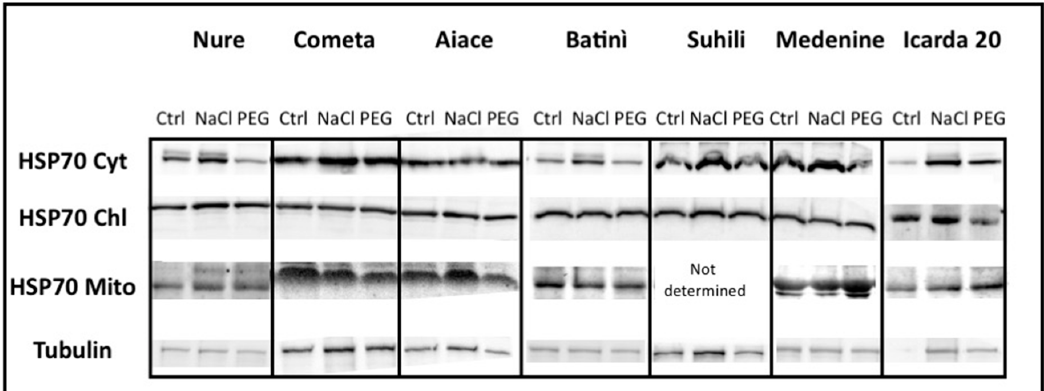
Figure 6. Immunoblotting of leaf extracts from different barley genotypes and landraces plants under control conditions (Ctrl) or exposed to salt stress (NaCl); or drought (PEG) collected after three days. Immunoblotting was performed by using antibodies raised abainst cytosolic (Cy-HSP70); chloroplastic (Chl-HSP70) and mitochondrial (Mito-HSP70). The control blots using anti-tubulin antisera are shown.